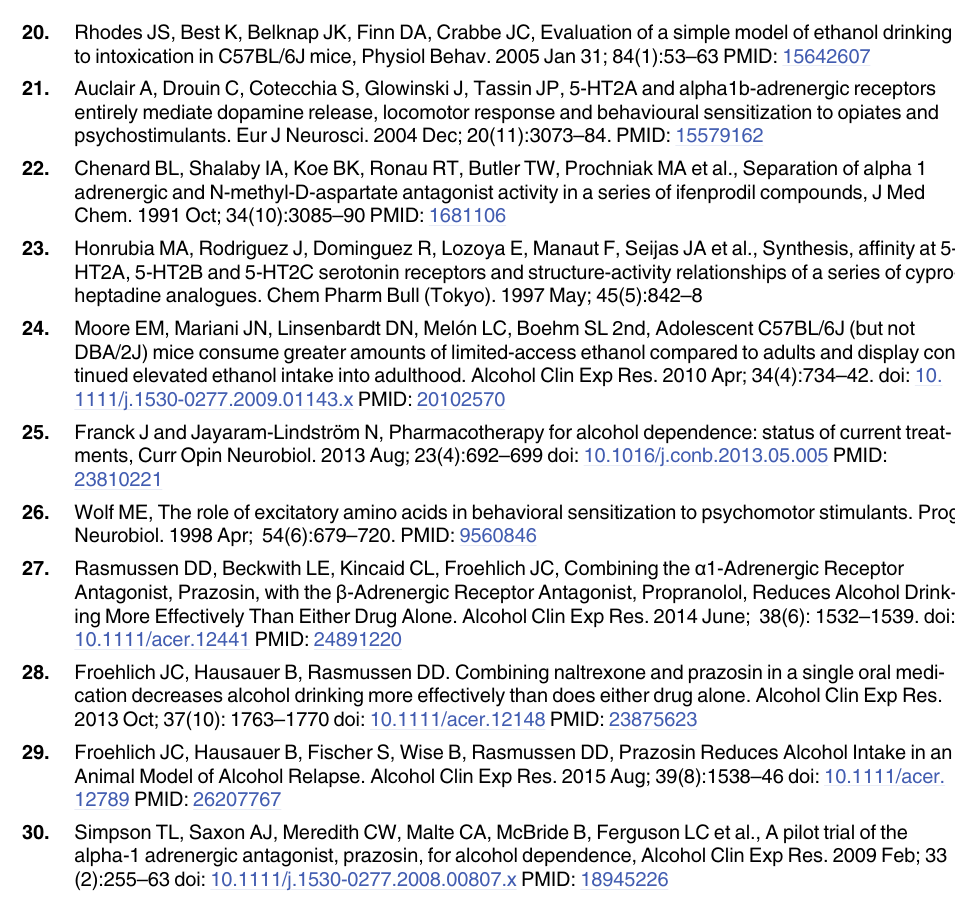
PLOS ONE | DOI:10.1371/journal.pone.0151242 March 11,